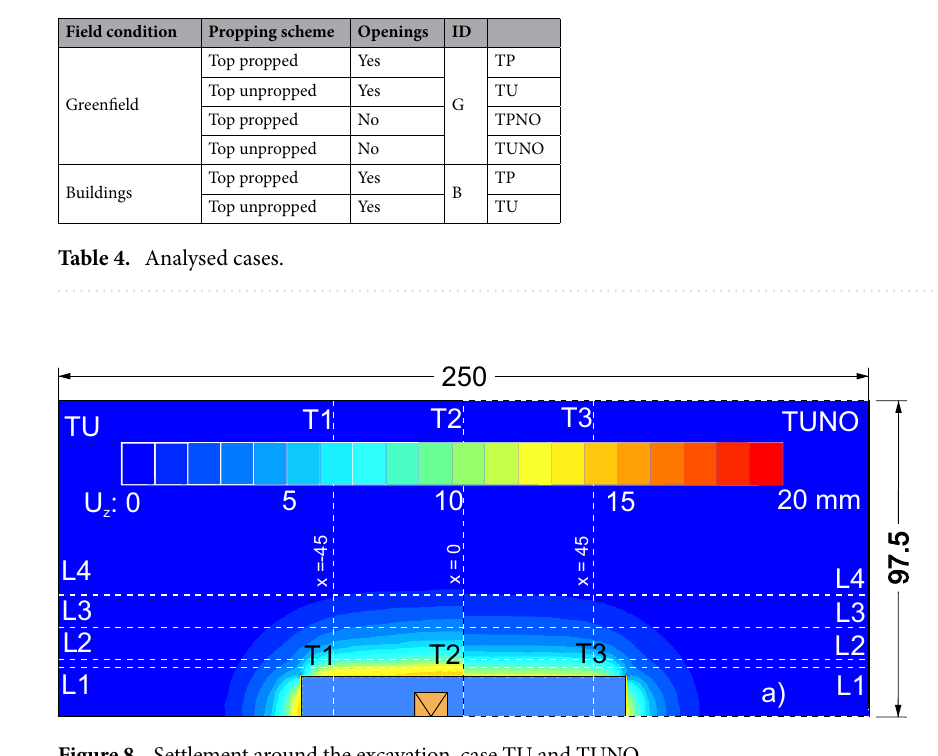
Figure 8. Settlement around the excavation, case TU and TUNO.